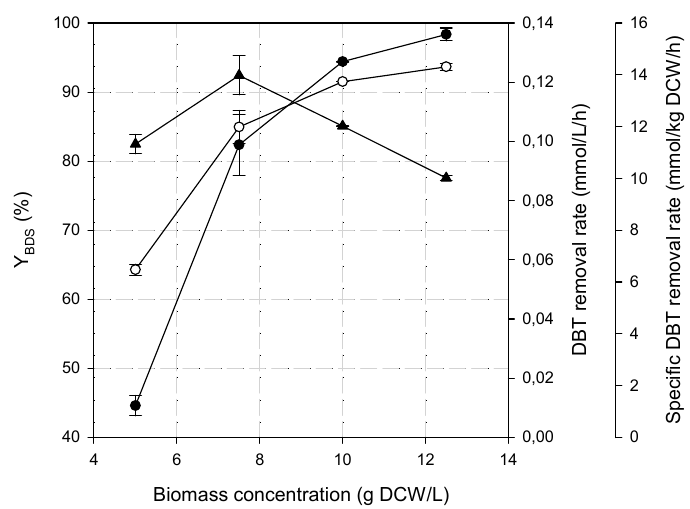
Figure 7. Effect of resting cell concentration on desulfurization of DBT. Symbols : ( λ ) Y BDS (%), ( ◯ ) DBT removal rate (mmol/L/h), and ( π ) specific BDT removal rate (mmol/kg DCW/h). At the highest cell concentration (12.5 g DCW/L), the specific desulfurization rate was almost 10 mmol/kg DCW/L. These results indicate that for the specific desulfurization setup, mass transfer limitations became significant from a cell concentration as low as 7.5